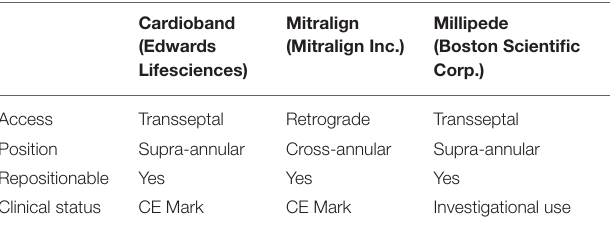
TABLE 1 | Currently available transcatheter direct annuloplasty systems (transapical approach devices have not been